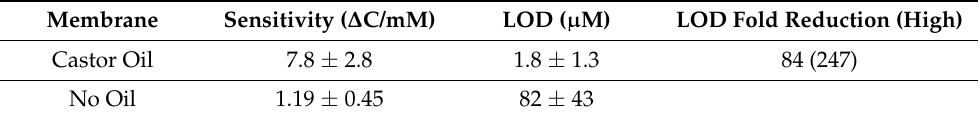
Table 2. Summary of the analytical performance of boron-doped diamond with and without inte- grated oil–membrane protection in human serum for hexacyanoferrate (II/III) titration.